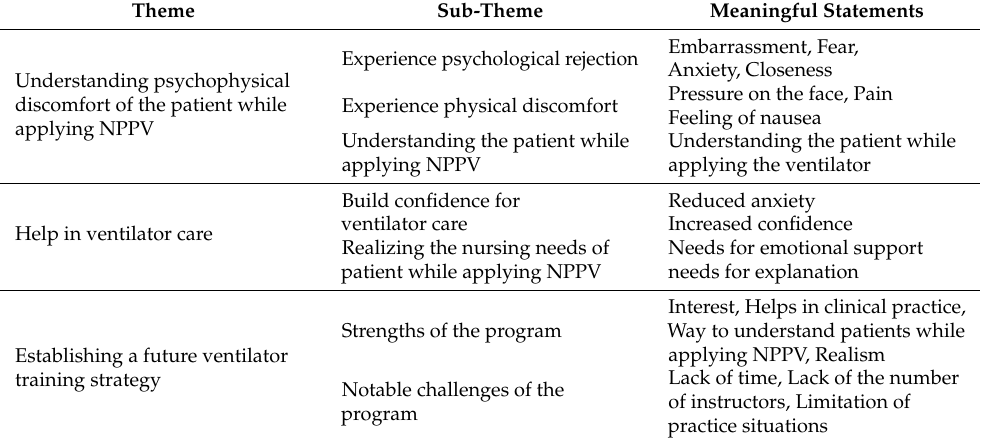
Table 4. Analyzing experience of the noninvasive positive pressure ventilator simulation program. Theme Sub-Theme Meaningful